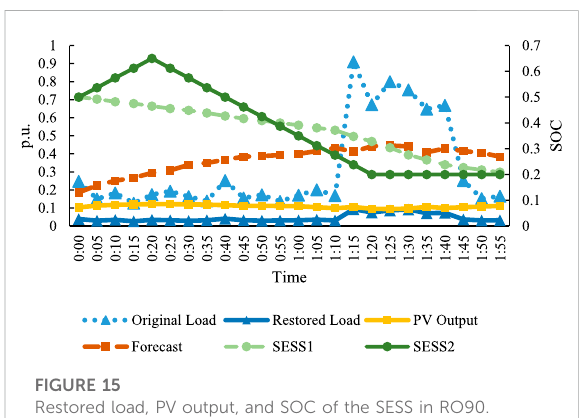
FIGURE 15 Restored load, PV output, and SOC of the SESS in RO90. FIGURE 16